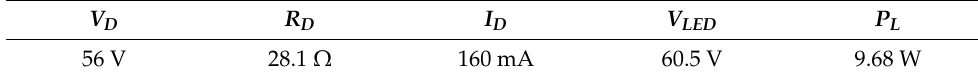
Table 3. Design parameters proposed.